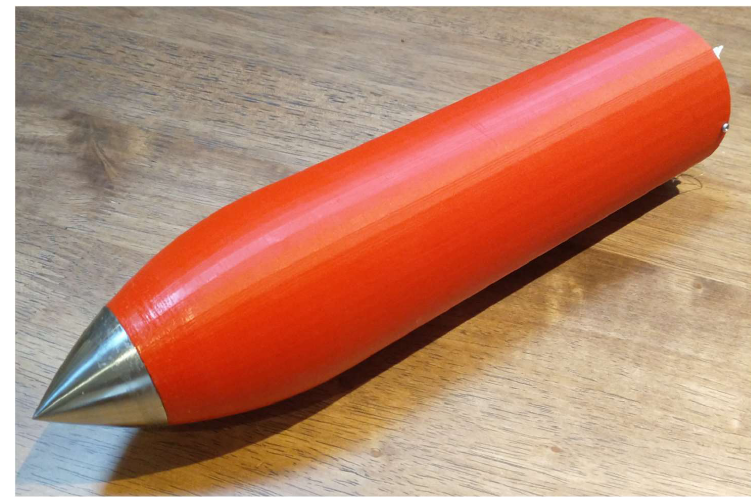
Figure 18. 3D printed casing and stainless steel tip mass.